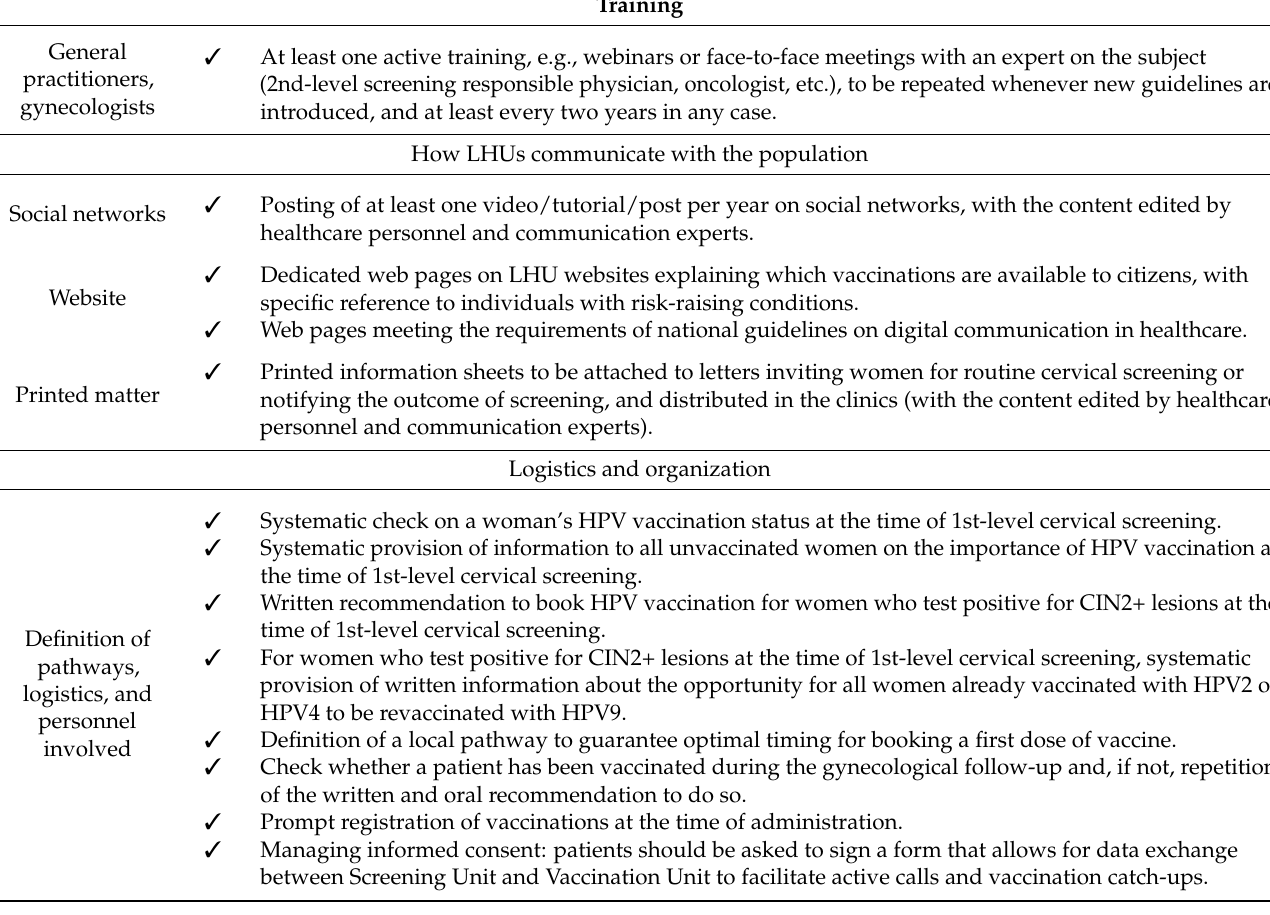
Table 3. Checklist of strategies to improve practices to reach the target population and implement the procedure